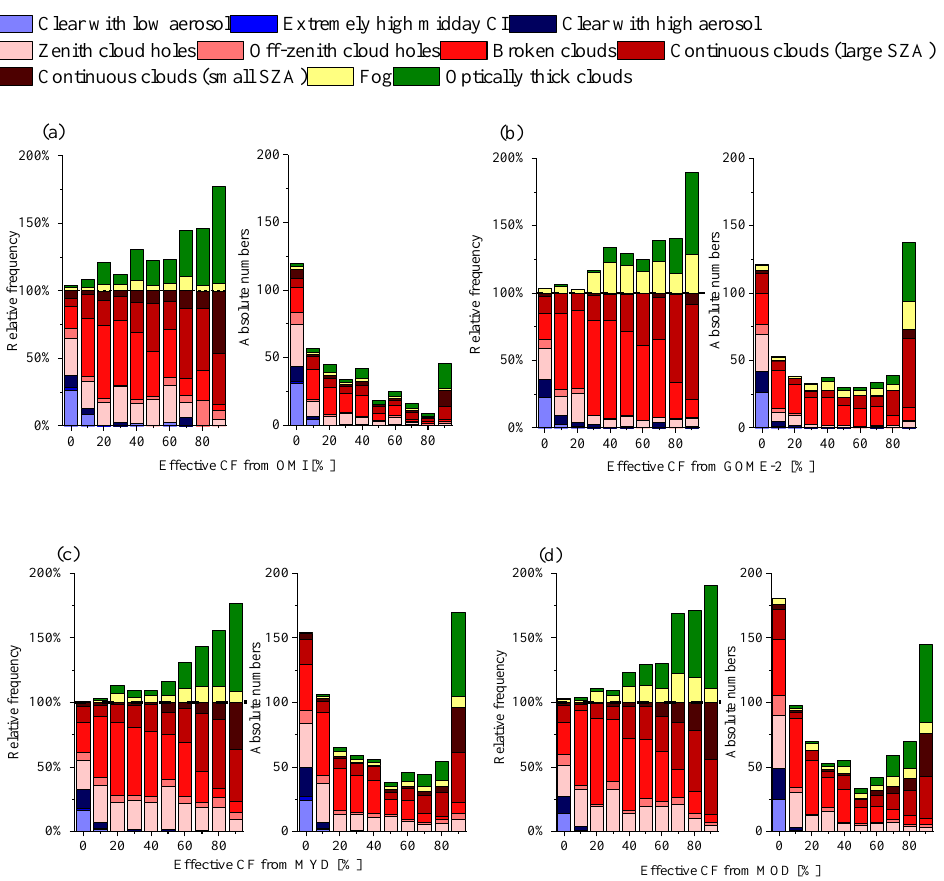
Figure 16. Results of the cloud classification scheme as a function of effective cloud fractions derived from (a) OMI, (b) GOME-2, (c) MODIS on Aqua (MYD) and (d) MODIS on Terra (MOD). The left parts of the figures present the relative frequencies of the dif- ferent sky conditions (see the caption of Fig. 10). The right parts of the figures present the absolute numbers of the sky conditions.